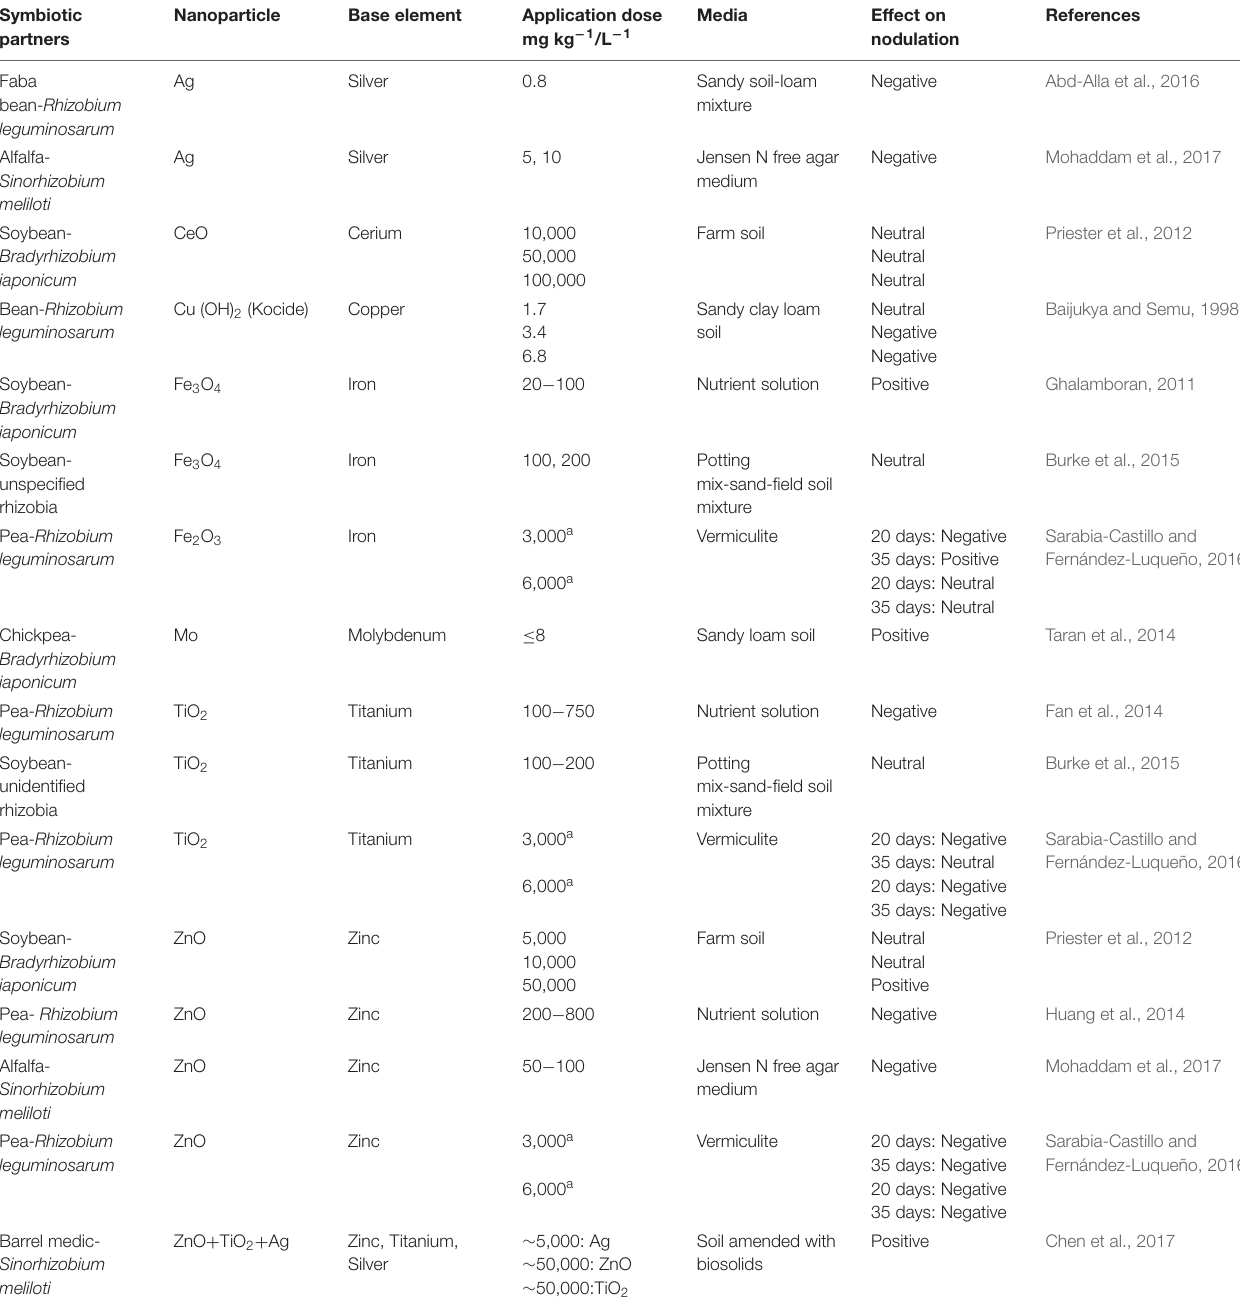
TABLE 1 | Effects of different nanoparticles on development of rhizobial